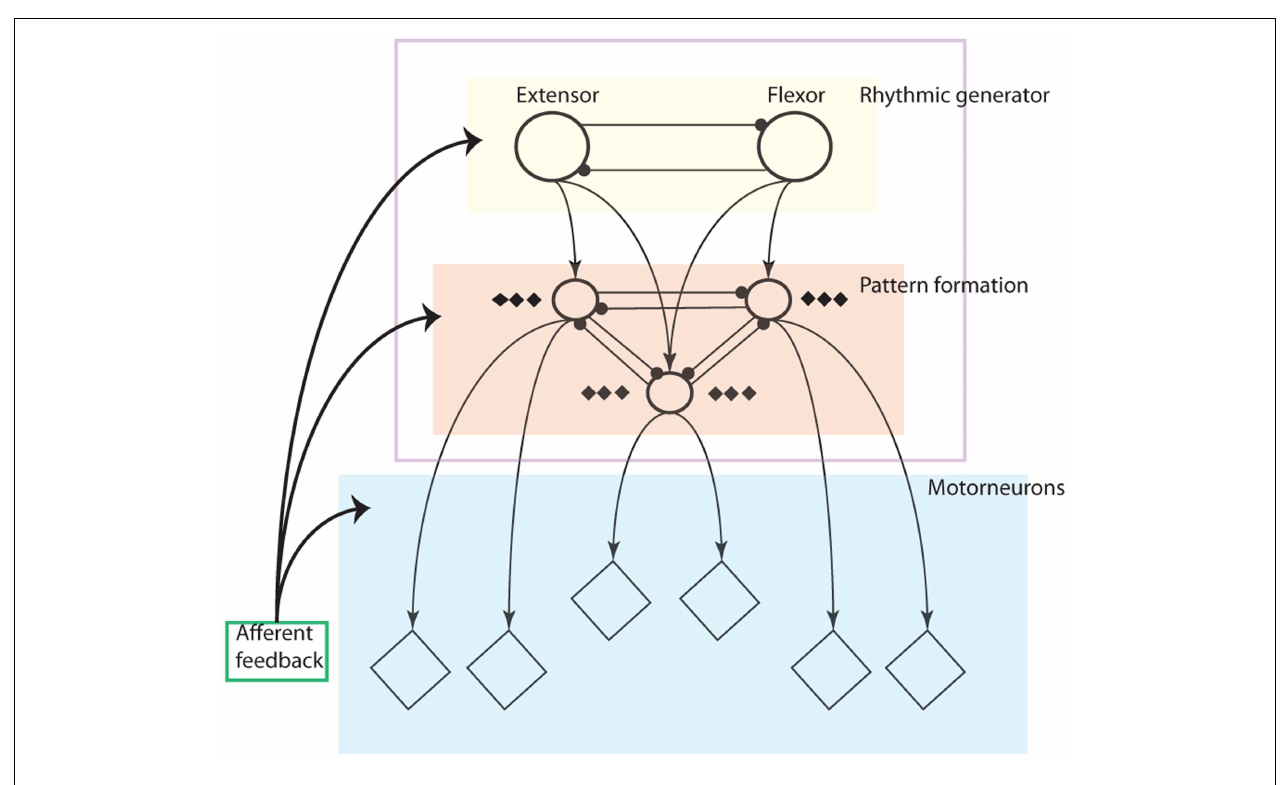
motorneuron pools (diamonds) and is connected with other PF populations via a network of inhibitory connections. It mediates rhythmic input from the RG to motorneurons and distributes it among the motorneuron pools.The network also synchronizes the oscillatory output of each interneuron.The motorneuron layer: It integrates the muscle sensory feedback and activation of PF network outputs.The extensor and flexor motorneurons together determine the output to the muscles (Rybak et al.,